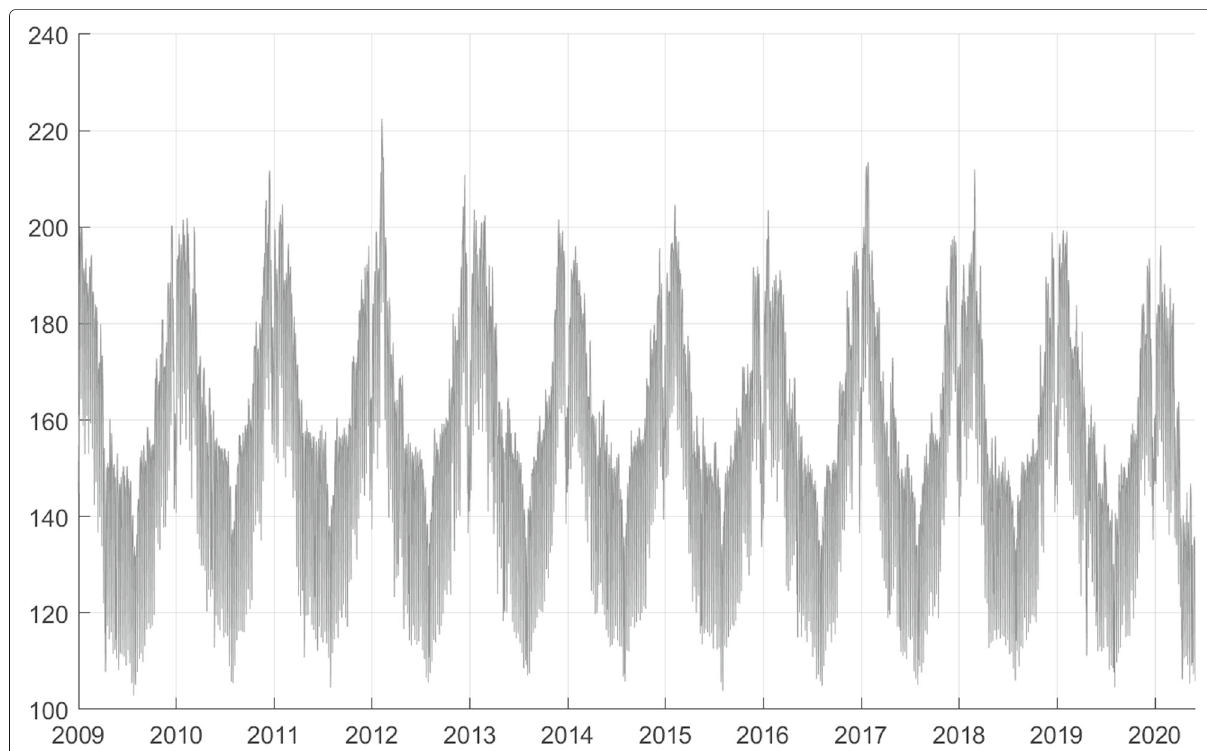
Fig. 1 Raw data: final consumption of electrical energy in Switzerland, aggregated to daily frequency [GWh], January 01, 2009, to May 31, 2020